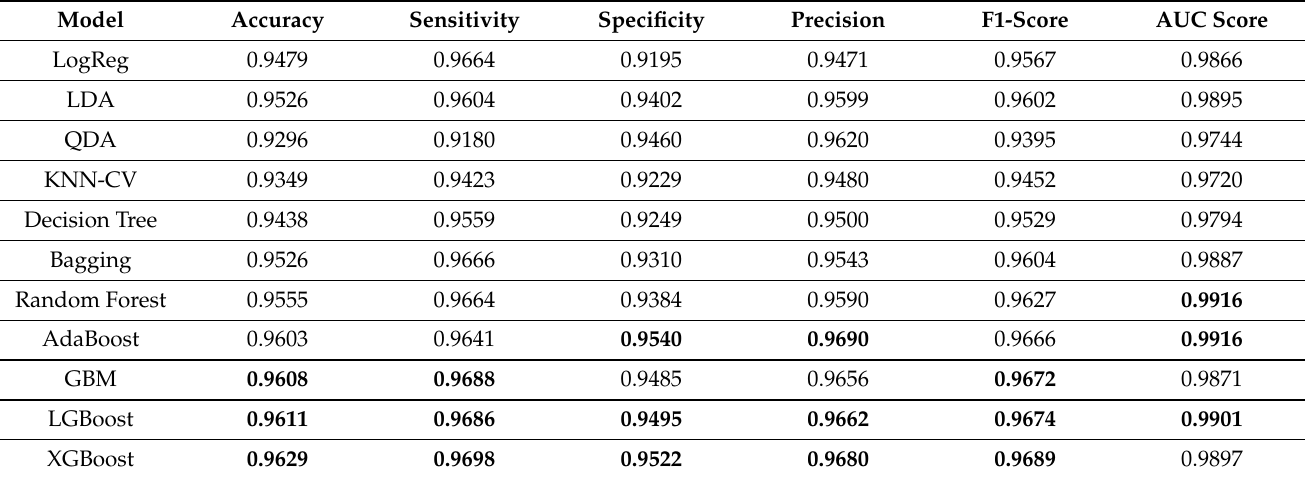
Table 5. Results for all models with the 25-s segmentation scheme using LOOCV. Top three results are highlighted for each